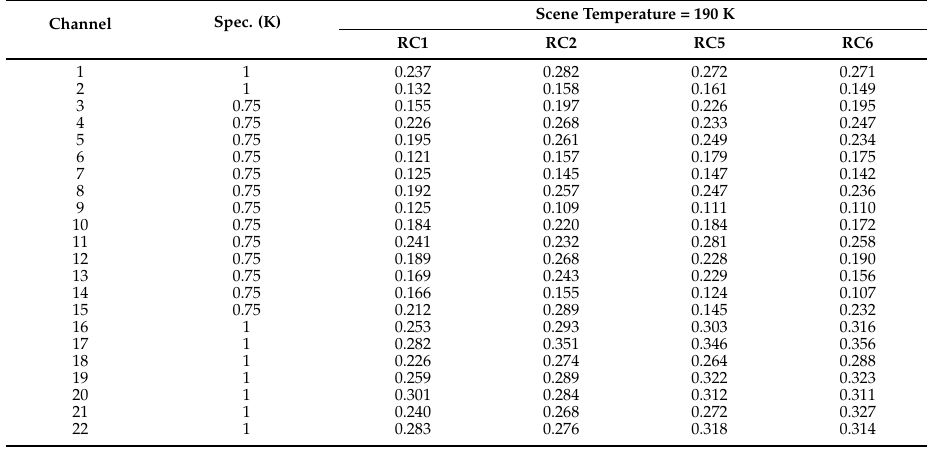
Table 4. SNPP ATMS PFM in-orbit calibration accuracy at mid-temperature scene for four redundant configurations (RC1, RC2, RC5,